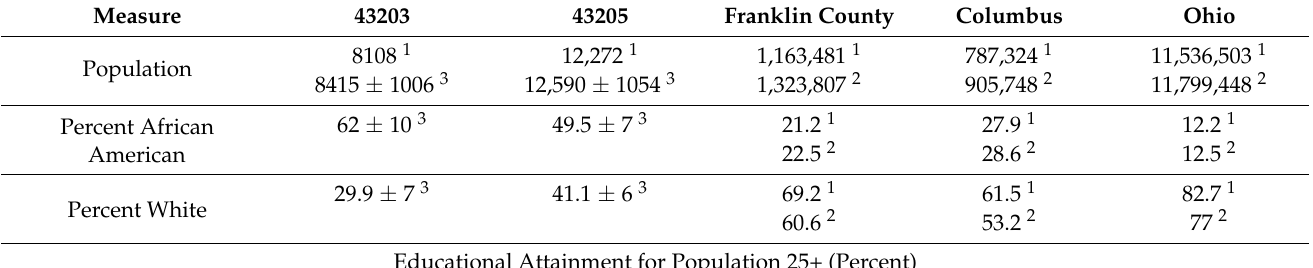
Table 1. Summary of socio-demographic and health indicators for the Near East Side by zip-code vs. Franklin County vs. Columbus City vs. the State of Ohio (See Cifuentes et al., 2019 [5] for details). [Reproduced and adapted with permission from the corresponding author of Cifuentes et al., 2019 on 18 October